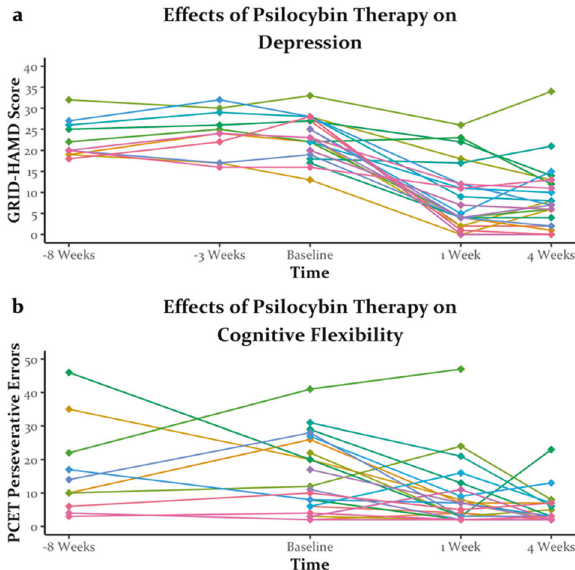
Fig. 1 The effects of psilocybin therapy on depression and cognitive fl exibility. Depression symptomology ( a ) as measured by the GRID-Hamilton Depression Rating Scale (GRID-HAMD; also reported in [3]) and cognitive fl exibility ( b ) as measured by perseverative errors on the Penn Conditional Exclusion Test (PCET) were improved from pre- to post-psilocybin therapy. These changes were not found between repeated tests pre-psilocybin therapy in the delayed group (i.e., between − 8 weeks and Baseline time points). Each line color represents a unique participant, and the mapping of individual colors to unique participants remains consistent across all fi gures in which individual participant data are